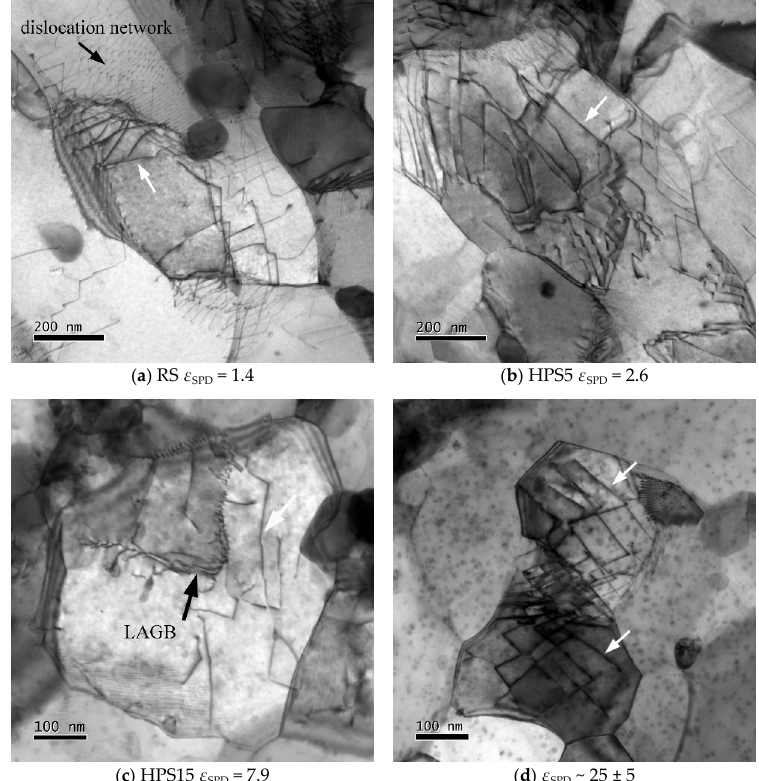
Figure 4. Microstructure (TEM) after annealing at 873 K for 5 h in ( a ) RS, ( b ) HPS5, ( c ) HPS15, and ( d ) HPT; note the higher magnification in ( c , d ).